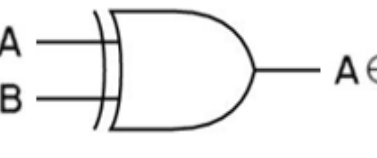
Figure 12. Classical XOR gate.